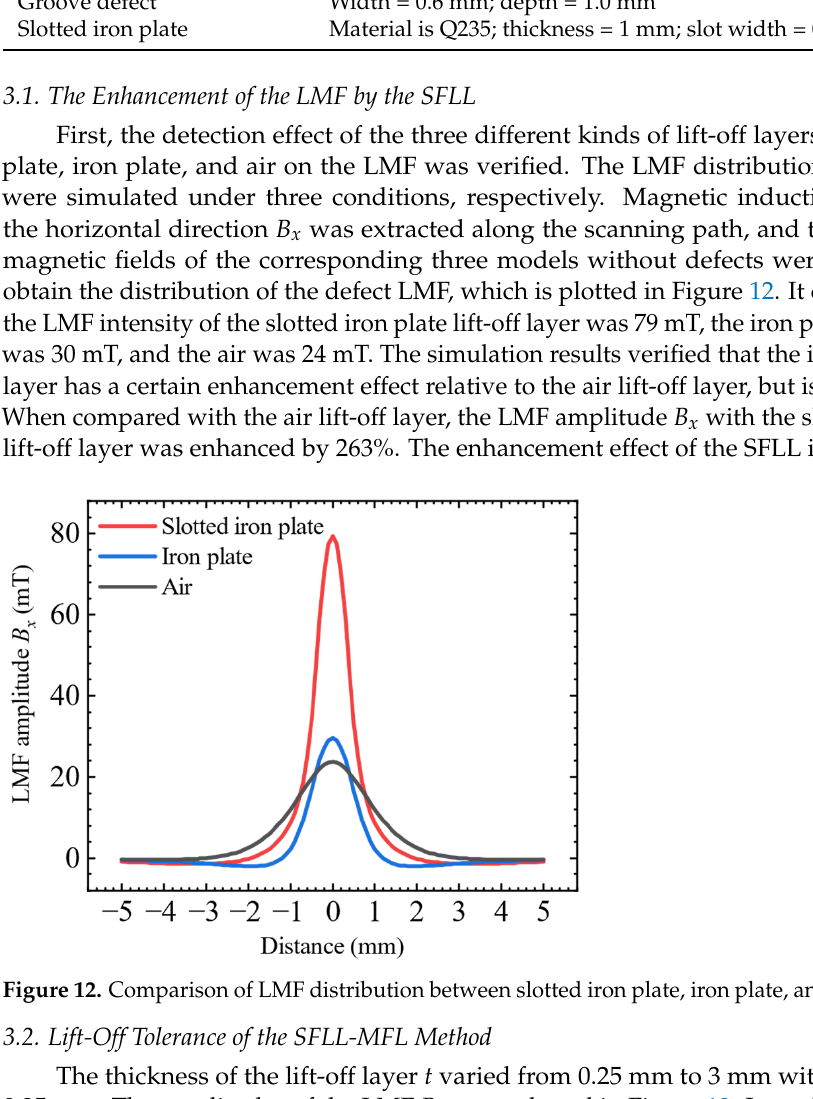
Table 2. The parameters of the 2D simulation model.